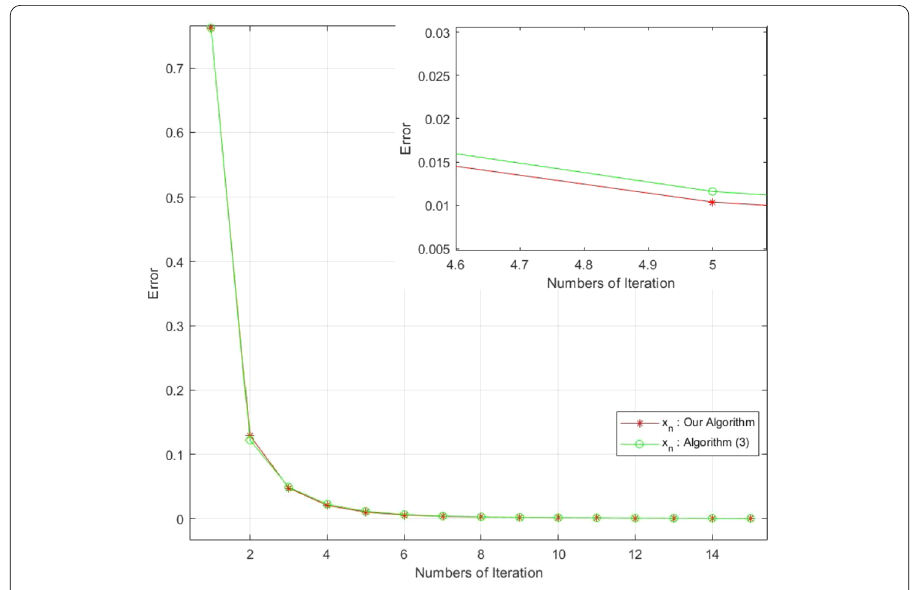
Figure 2 Comparison between Algorithms (21) and (3) for Example 2 with u = 3 t and N = 15